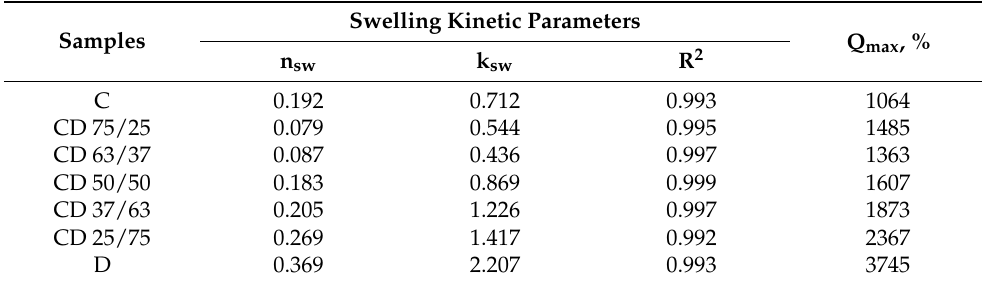
Table 2. Swelling kinetic parameters for different hydrogel